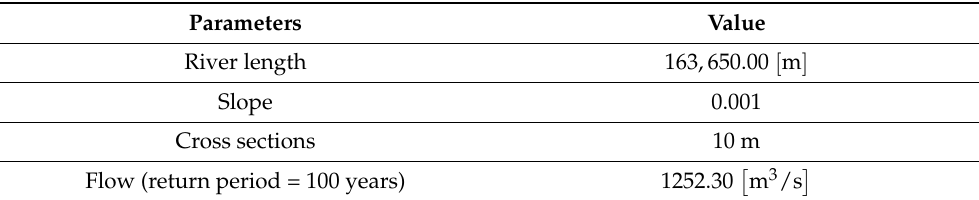
Table 8. Initial conditions for hydraulic